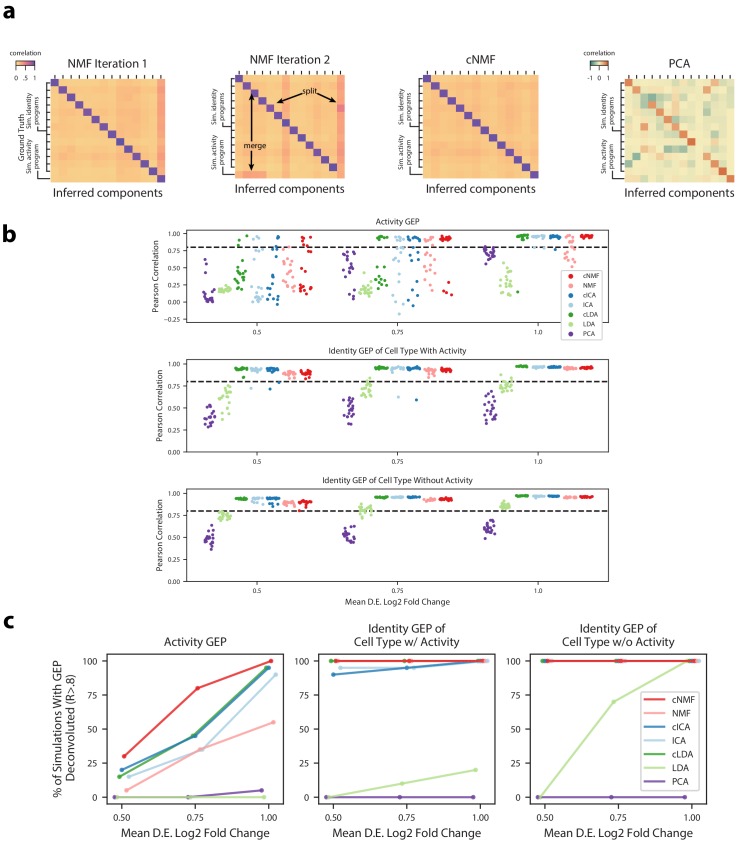
Deconvolution accuracy of matrix factorization methods.(a) Pearson correlation between ground truth GEP means (rows) and GEPs inferred by different iterations of NMF (left), cNMF, or PCA (right) for an example simulation. All correlations are computed considering only the 2000 most over-dispersed genes and on vectors normalized by the computed sample standard deviation of each gene. Arrows annotate cases where GEPs were merged into a single component or a GEP was split into two components. (b) Pearson correlation between inferred GEPs and true simulated GEPs for several matrix factorization methods across all 20 simulation replicates for each average signal level. (c) Percentage of simulation replicates for which GEPs of each type had a pearson correlation of R > 0.8 with the true simulated GEP, as a function of the average signal level.